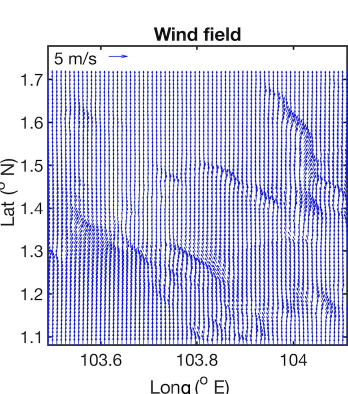
Figure 4. The 2D plot of ground-level diagnostic wind field calcu- lated by MCWIND for the simplified dispersion